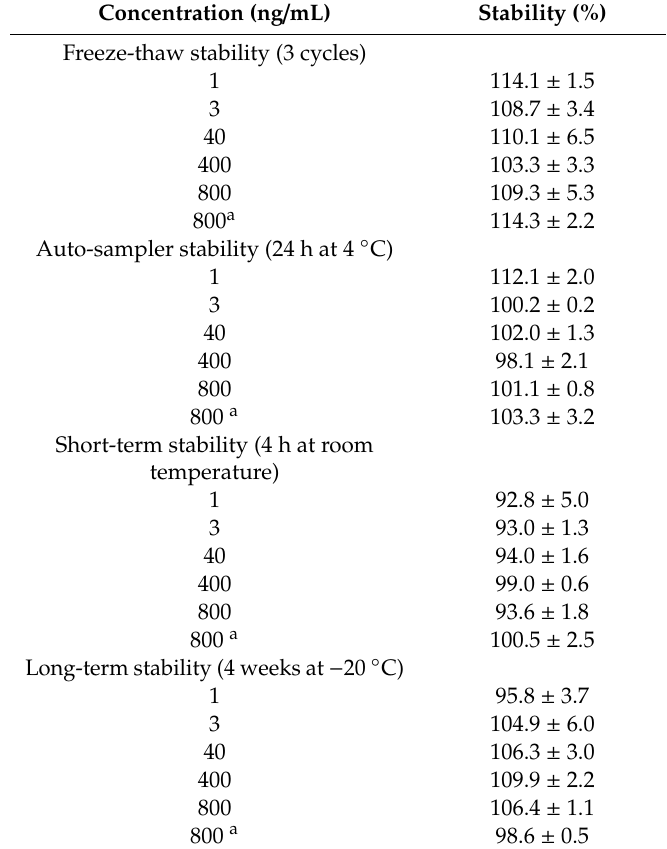
Table 3. Stability of KD025 in rat plasma (n =